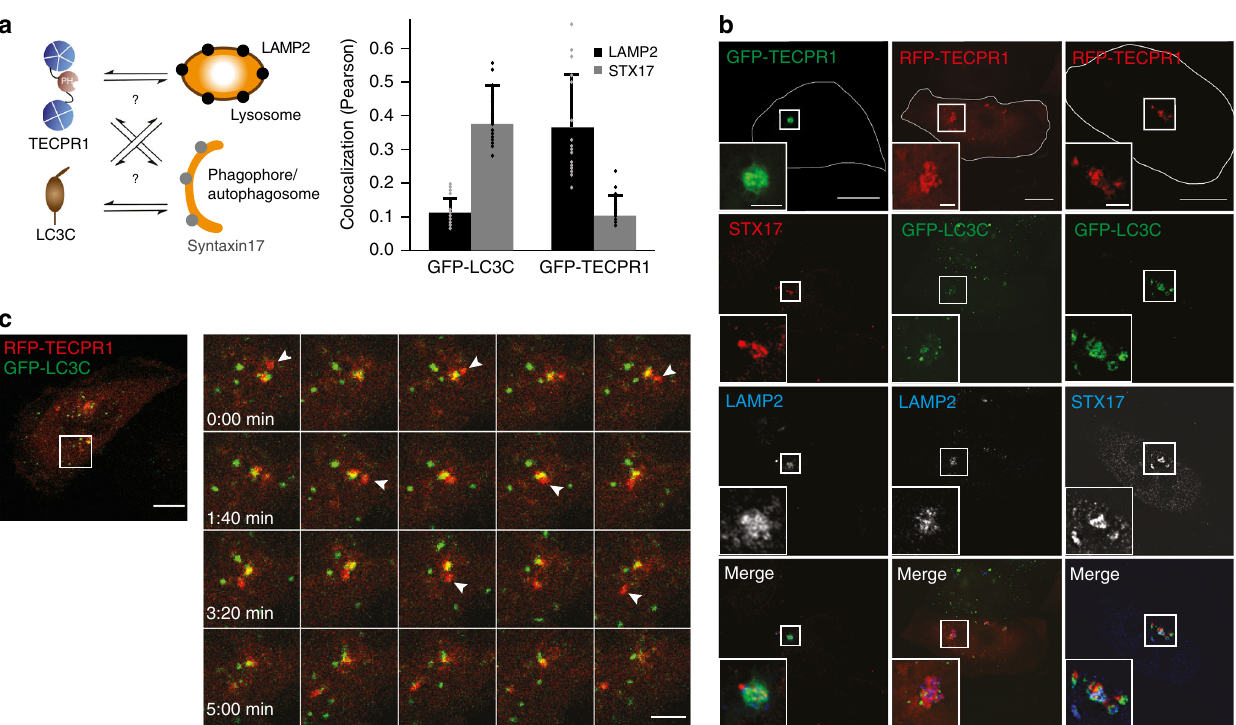
Fig. 3 TECPR1 recruits LC3C vesicles to lysosomes. a Quantitative analysis of the colocalization of GFP-LC3C and GFP-TECPR1 with immunostained LAMP2 and STX17 in starved HeLa cells ( n = 20 cells pooled from three independent experiments). Data are represented as mean ± SD. b Structured- illumination microscopy of starved HeLa cells expressing GFP-TECPR1 or RFP-TECPR1 together with GFP-LC3C as indicated. Cells were fi xed and immunostained for LAMP2 or STX17. LC3C puncta are in the immediate vicinity of TECPR1/LAMP2 compartments. Scale bars, 10 µ m, insets, 2.5 µ m. c Time-lapse video microscopy of TECPR1 KO cells coexpressing RFP-TECPR1 and GFP-LC3C. Confocal images were captured every 10 s and every other frame is shown. Arrows indicate moving structures that transiently interact. Scale bar, 10 µ m, insets, 2.5 µ m. See also Supplementary Movies 1, 2, 3 and 4. Source data are provided as a Source Data fi